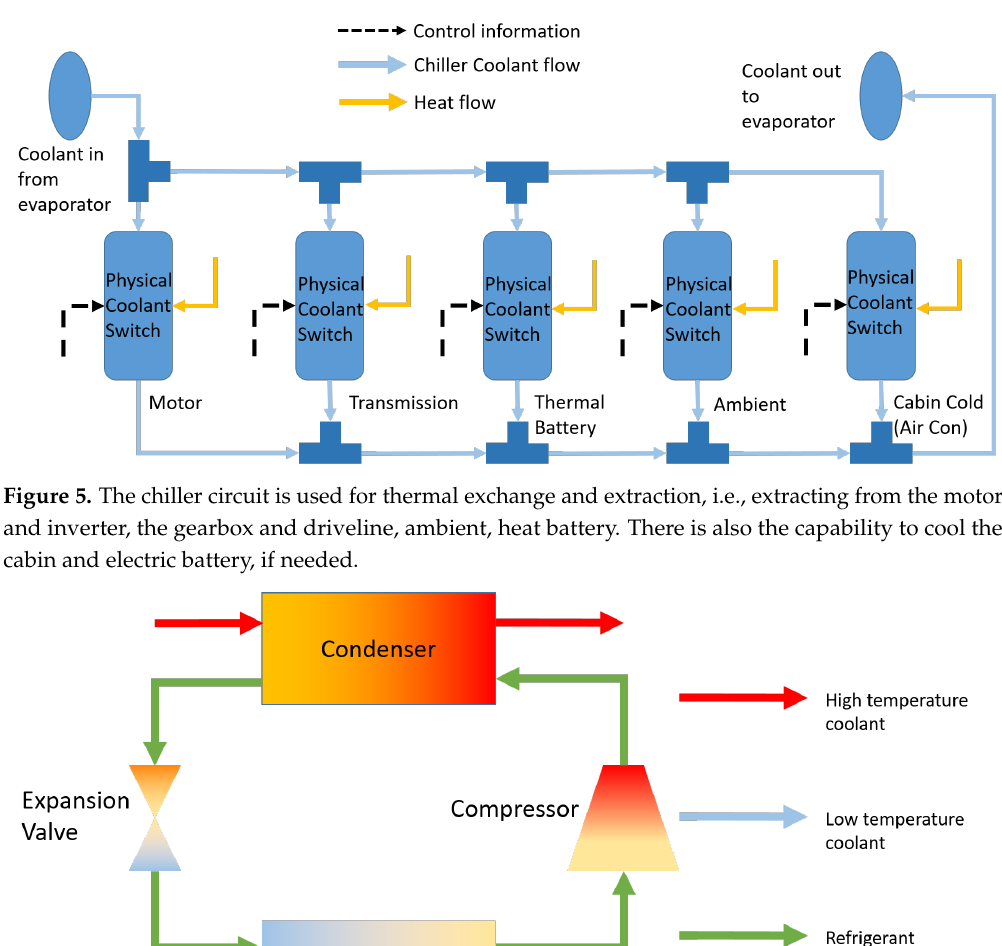
Figure 4. The coolant loop used for high temperature components, i.e., cabin and battery heating, positive thermal coefficient (PTC) input, heat battery input, and rejecting heat to ambient for air conditioning operation.